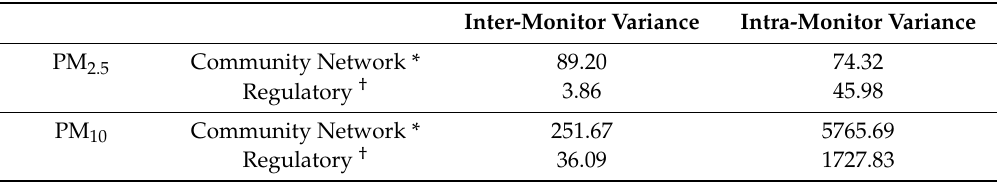
Table 2. Inter- and intra-monitor variance from restricted maximum likelihood estimation of 24-h average measures of PM 2.5 and PM 10 for Community Network (IVAN) and regulatory